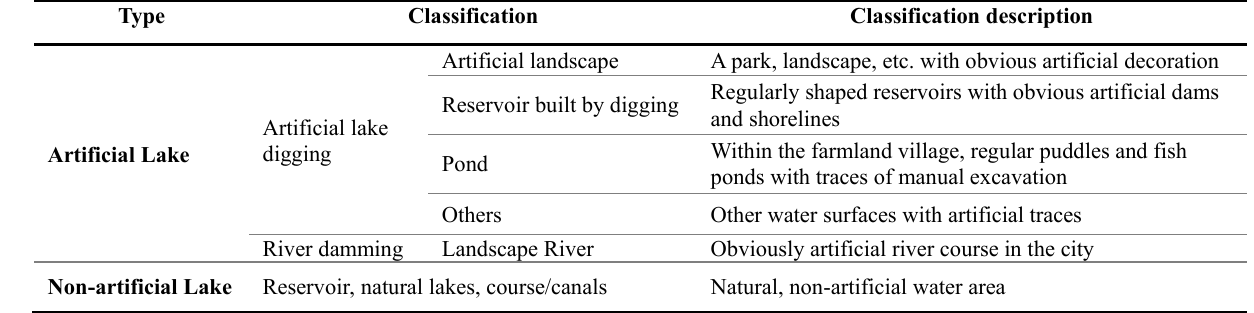
Table 2 . The classification standard of the artificial lake